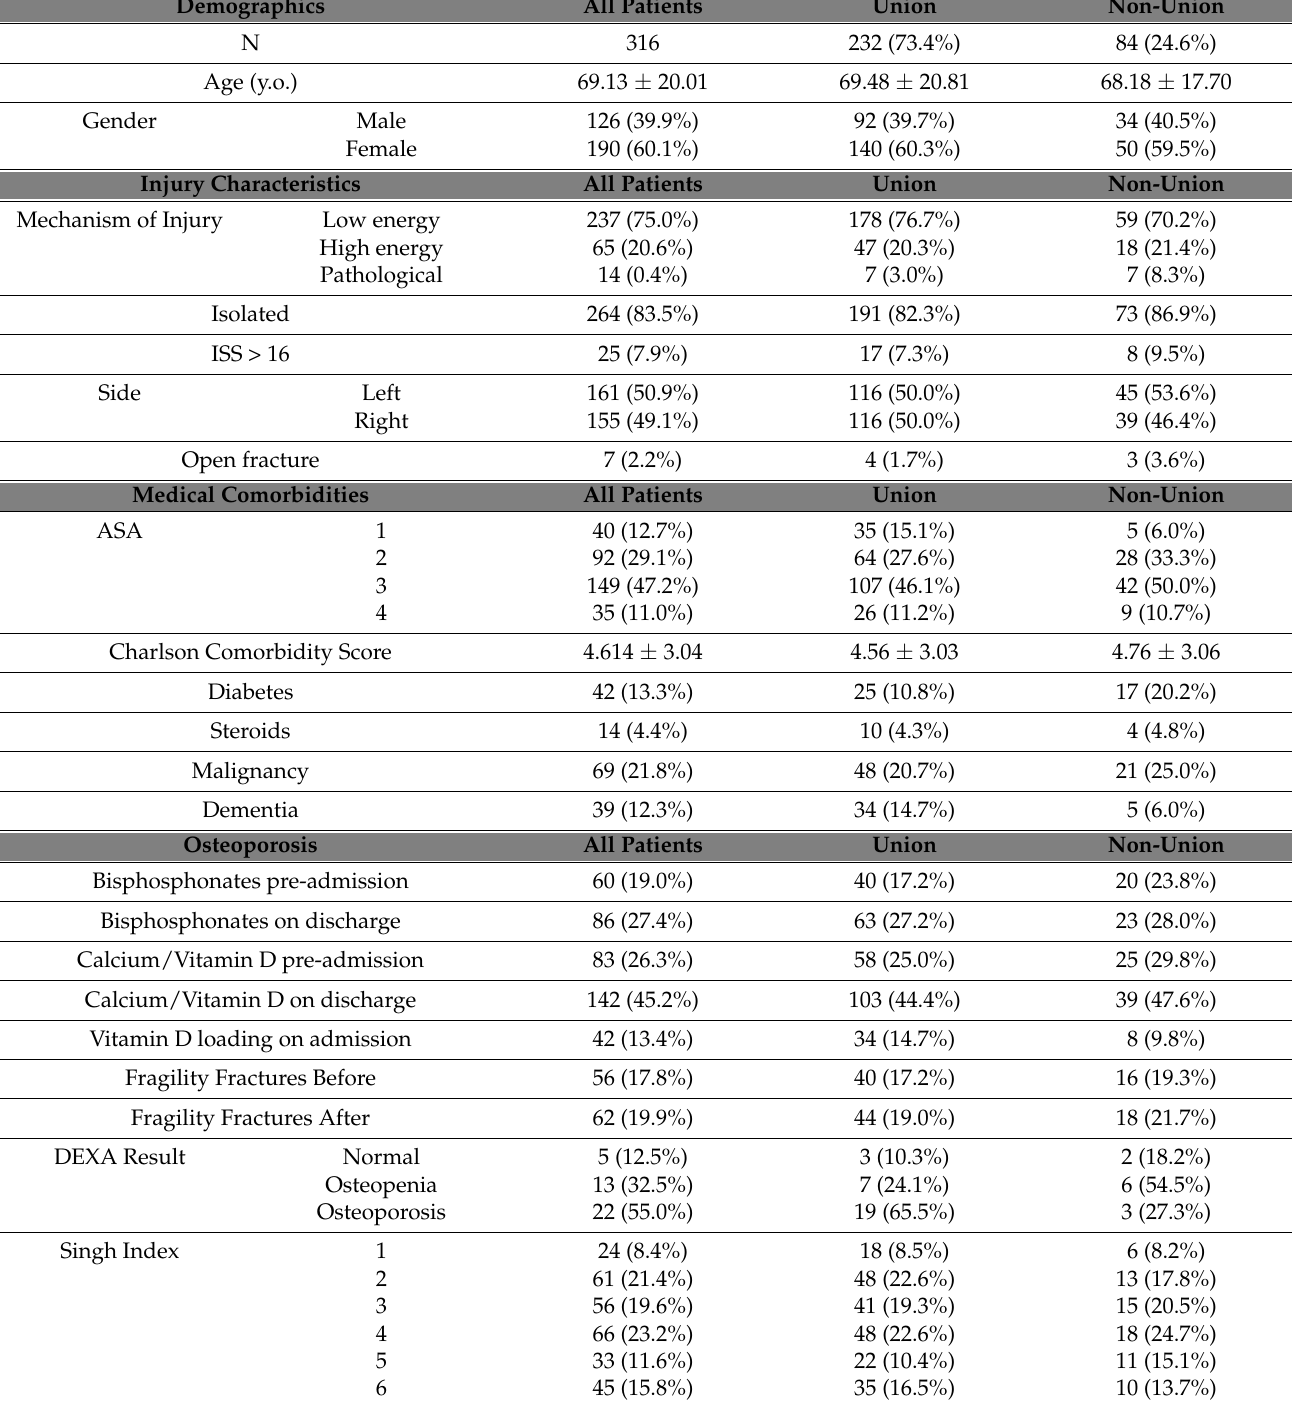
Table 1. Table presenting the demographics/characteristics of patients having their operation in our institution, with complete follow-up, stratified according to the progression to a non-union. Demographics All Patients Union Non-Union N 316 232 (73.4%) 84 (24.6%) Age (y.o.) 69.13 ± 20.01